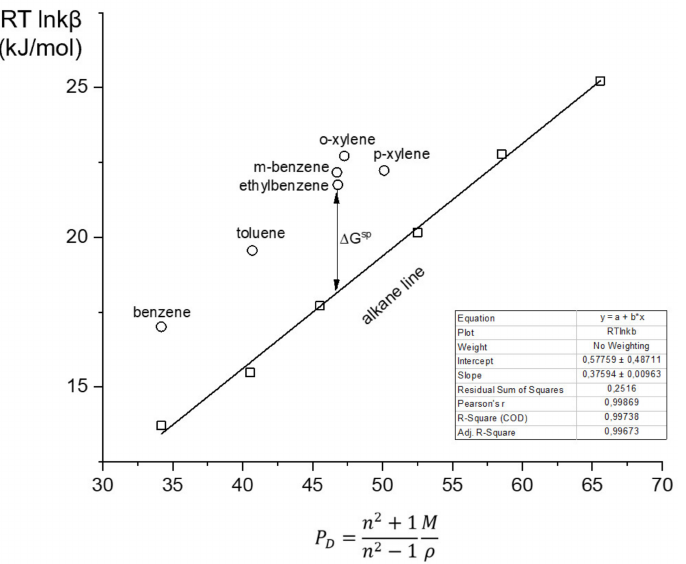
Figure 7. Diagram illustrating the evaluation of the specific free energy ( ∆ G SP ) by the polarization